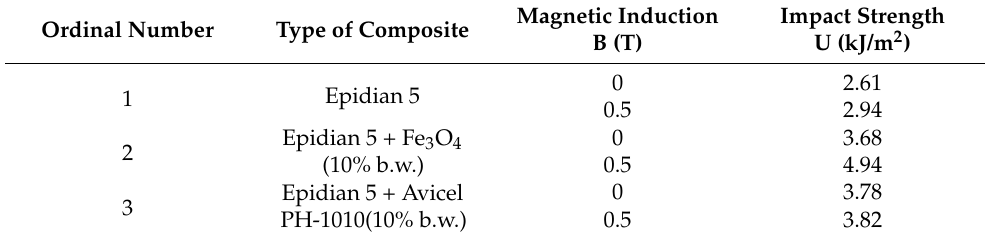
Table 11. Impact strength of selected